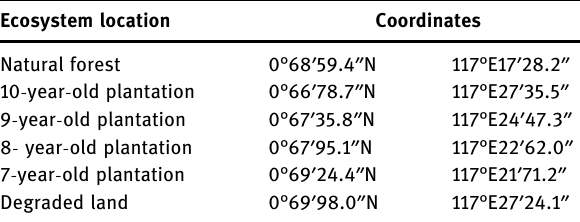
Table 1: Ecosystems location Ecosystem location